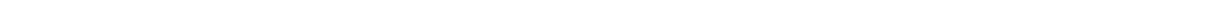
Fig. 1 Assembly and mechanical analysis of 3D photodetector structures from 2D materials. a Schematic illustration of processes for fabricating the 3D systems. b FEA results describing the formation of arrays of photodetectors based on graphene and MoS 2 in the form of an octagonal prism, and corresponding colorized SEM images of the fi nal con fi guration including MoS 2 (green), graphene (light gray), and SU-8 (gray). c , d Similar FEA results for the cases of an octagonal prismoid and a hemisphere. Colors represent the magnitude of the maximum principal strain. e Central angle and radius of a cross-section of the hemisphere in d vs. the released pre-strain. Here, the insets denote an intermediate state ( ε released = 21.4%) and the fi nal state ( ε released = 46%) of pre-strain release, with the dashed and solid lines representing the pro fi les from FEA and fi tting arcs, respectively. f FEA results and analytic predictions of the height of three photodetector structures in b – d . g Computational study of tensile strain applied to the SU-8, graphene, and MoS 2 layers vs. pre-strain during the 3D assembly (squares, circles, and triangles denote the octagonal frustum, hemisphere, and octagonal prism, respectively). h Experimentally measured variation in the resistance in graphene during repeated buckling